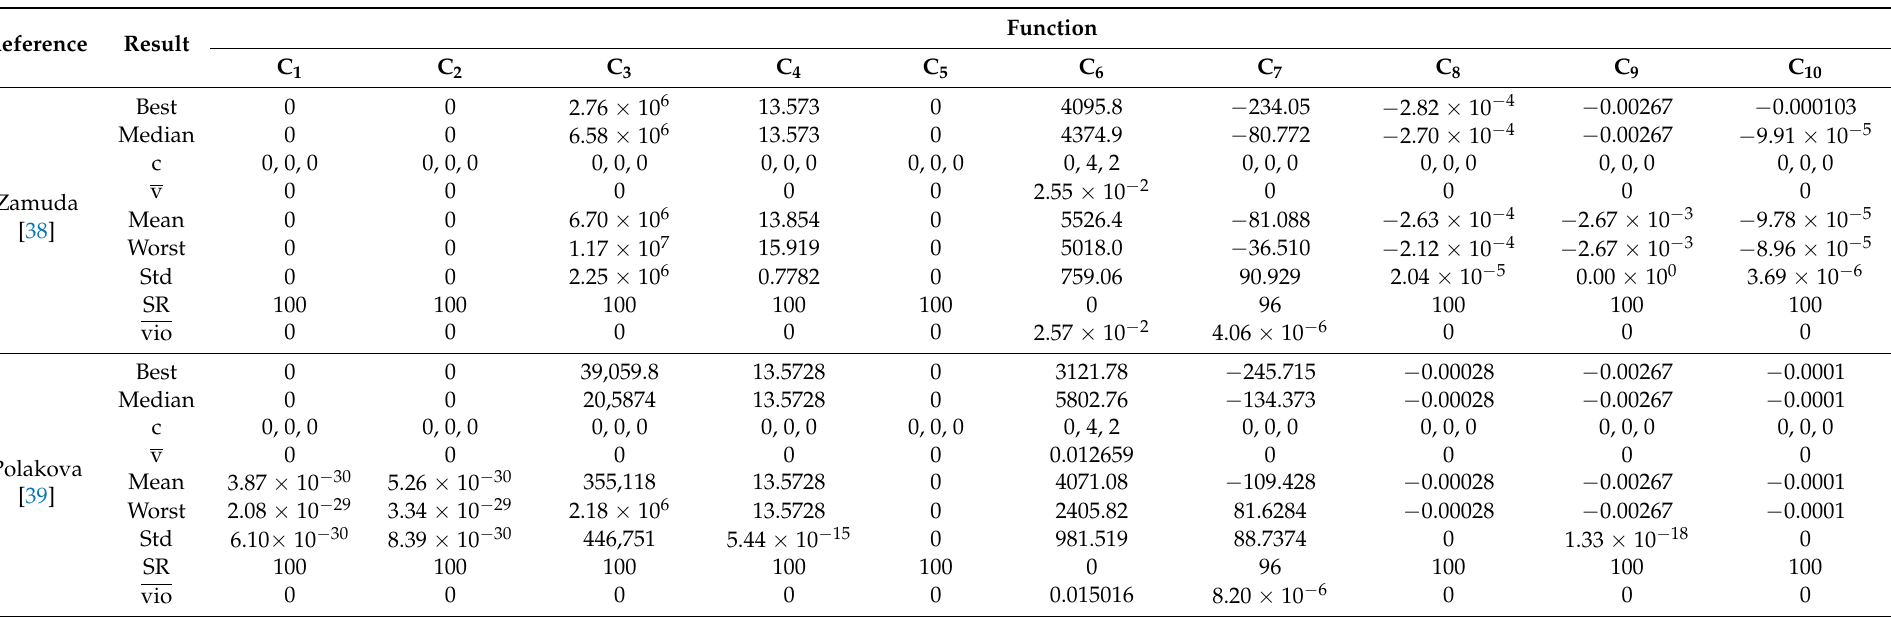
Table 5. Statistical results of different approaches for mathematical problems of CEC 2017 with 30